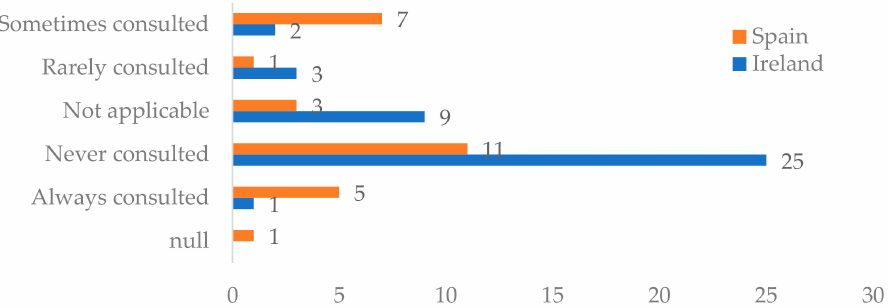
Figure 7. Level of stakeholder consultation on RE, including MHP in Ireland and